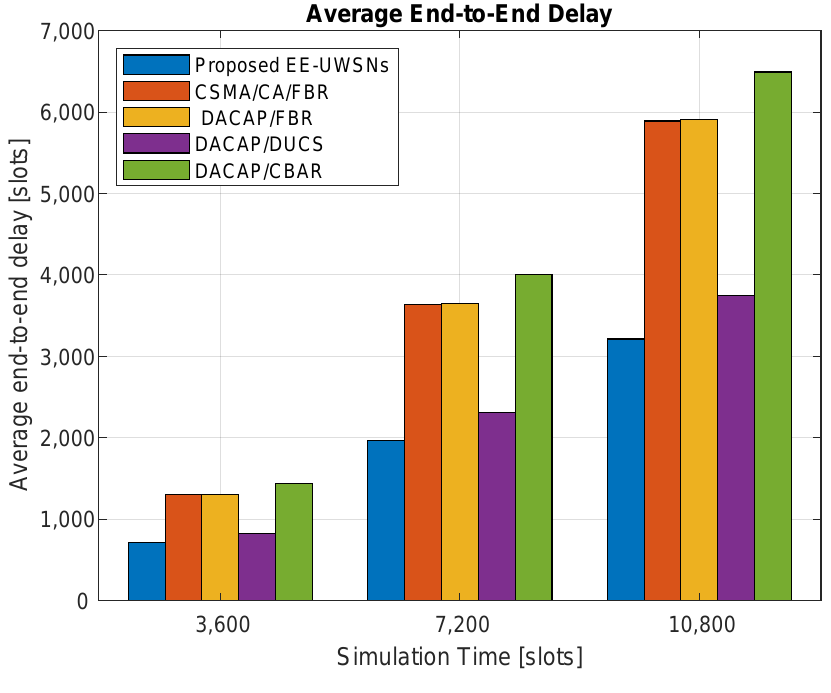
Figure 11. Average end-to-end